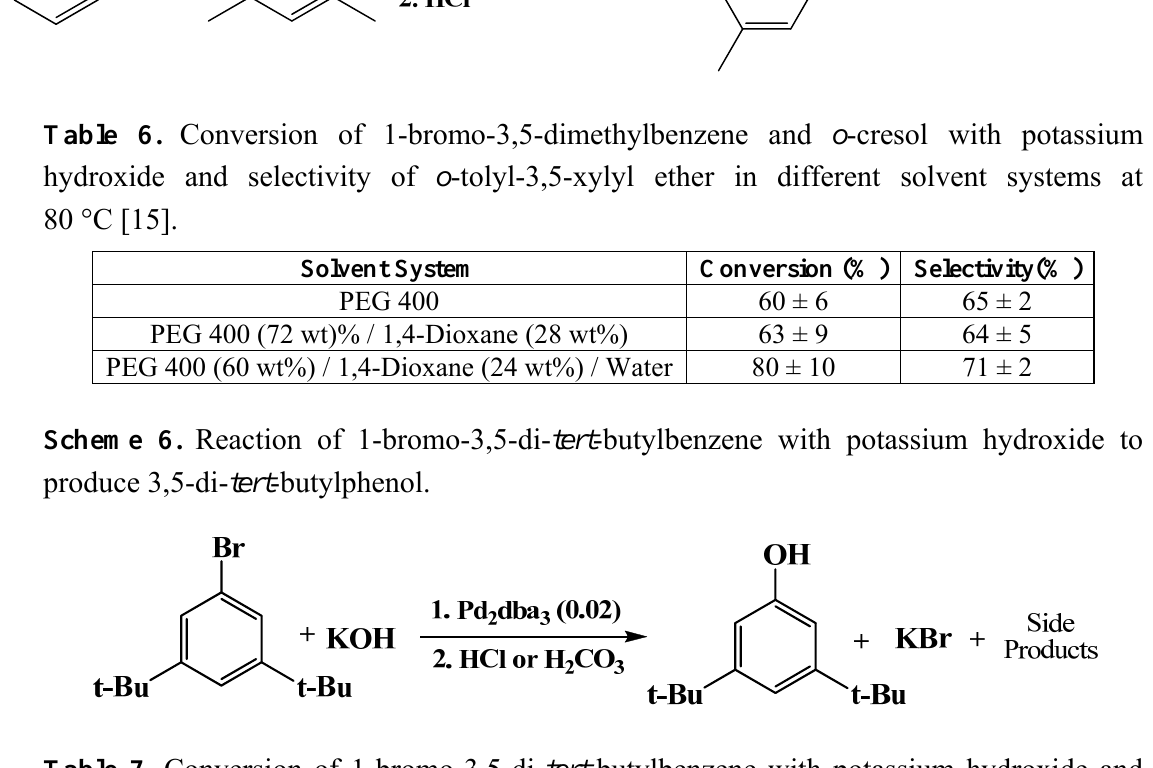
Table 7. Conversion of 1-bromo-3,5-di- tert -butylbenzene with potassium hydroxide